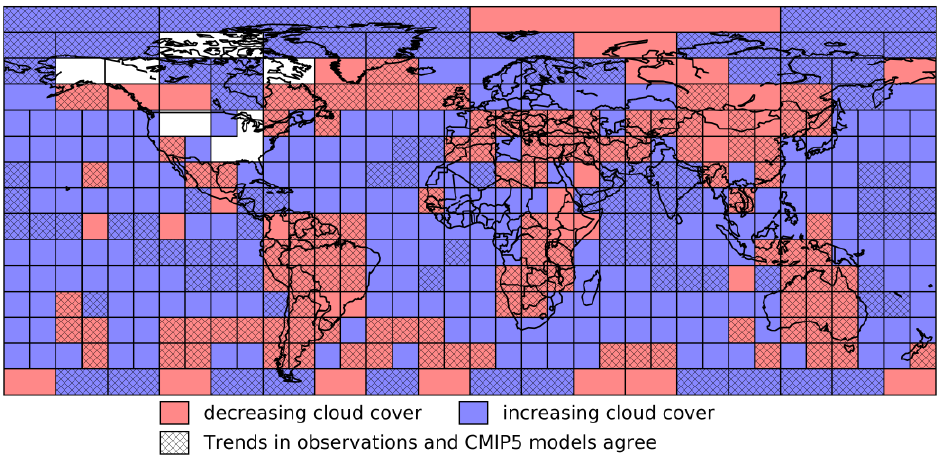
Figure 12. Changes in observed (NDP026) and CMIP5-simulated cloud cover are consistent with a CO 2 -induced down-regulation of stomatal conductance, resulting in reduced transpiration. Trends from observations are shown as decreasing (red) or increasing (blue) annual average cloud cover for 1971–2005: Red would tend to support our hypothesis of reduced transpiration and cloud cover as a result of stomatal down-regulation. If the CMIP5 trend and the observed trend have the same sign, the corresponding box is hatched. Location and shape of boxes corresponds to the coverage in the observational dataset, the 1971–2005 comparison period represent the overlap between the observational dataset and the historical CMIP5 runs. A change during the mid-1990s in cloud cover observation methodology in the US precluded their use in trend evaluation in NDP026. A chi-squared test between the two data sets rejected the null-hypothesis that they are independent ( p = 0.05). Chi-squared tests performed on the two data sets at seasonal scales yielded the following p -values: December January February (0.22), March April May (0.05), June July August (0.26), and September October November